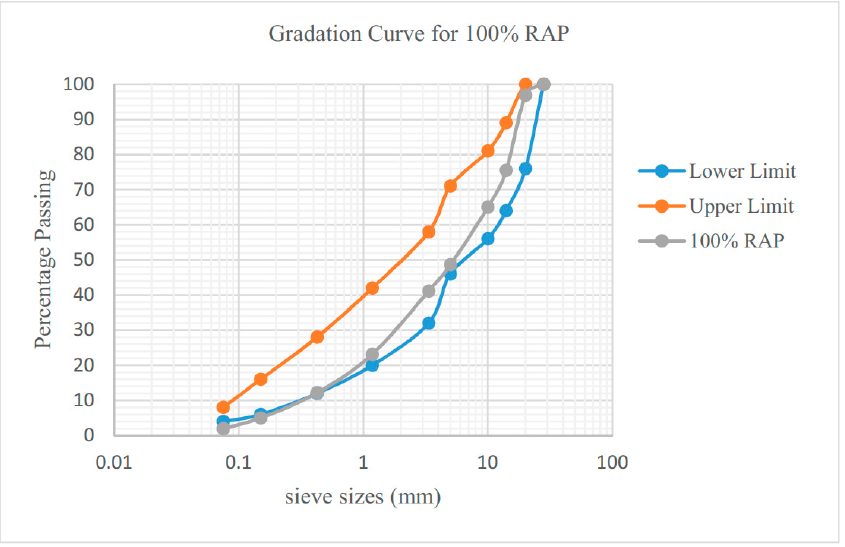
Figure 3. Extracted RAP gradation Curve.